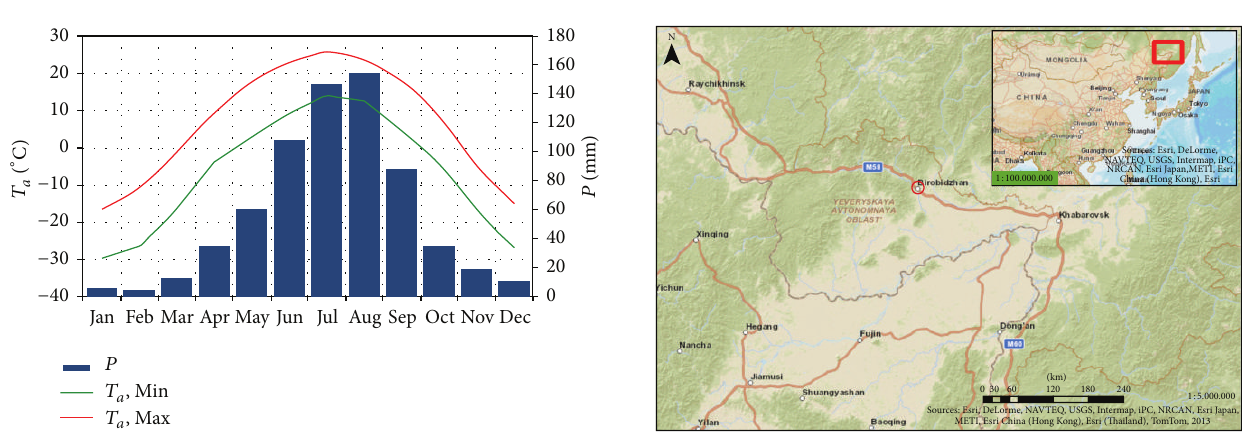
Figure 1: Climate diagram for the Birobidzhan area (data source: http://worldweather.wmo.int/).